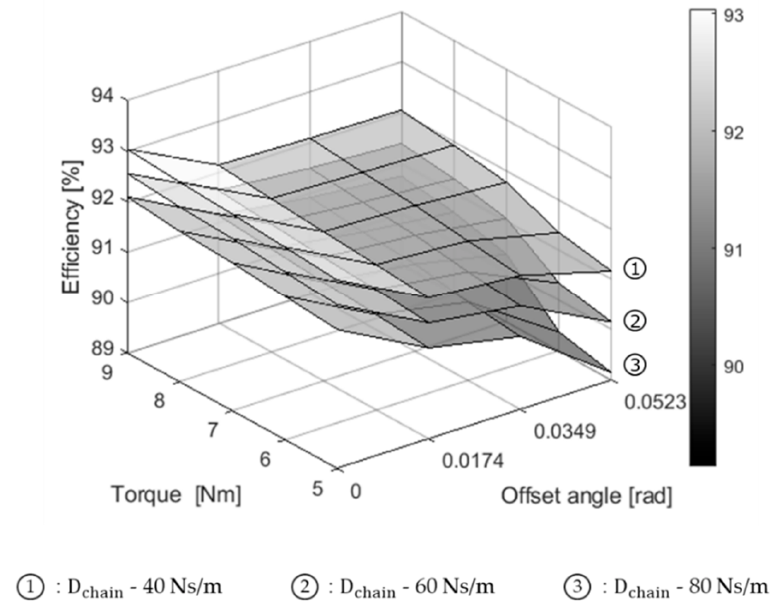
Figure 7. Transmission efficiency as function of torque, offset angle, and damping coefficient.